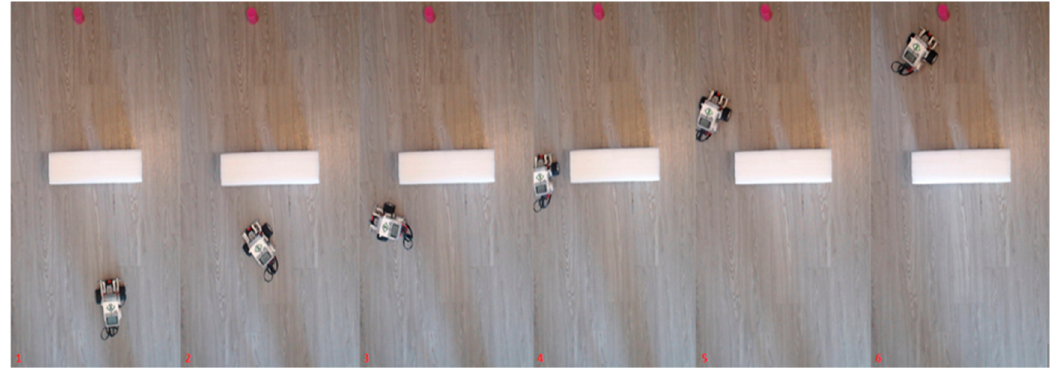
Figure 16. Experiment setup; 2. Scenario—robot motion control from start (1) and goal (6) position.